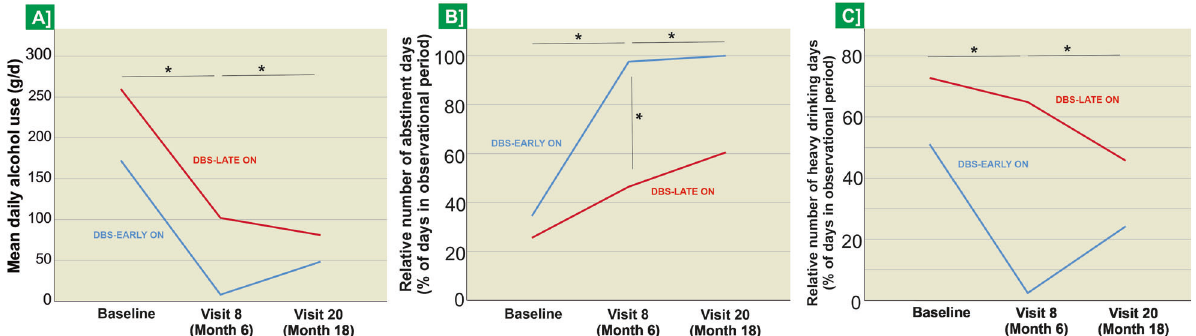
Fig. 4 Effect of NAc DBS on alcohol use, abstinent days and heavy drinking days. Depiction of median values and of signi fi cant longitudinal changes and group differences in A mean alcohol use (mean over last 30 days), B proportion of abstinent days, and C the proportion of heavy drinking days, at baseline, at the 6-month visit (i.e., end of blinded phase), and at 18 months (after all patients had been actively stimulated for at least 12 months). *Signi fi cant differences between time points or study groups, as indicated, at p < 0.05, determined using Wilcoxon tests and Mann – Whitney U